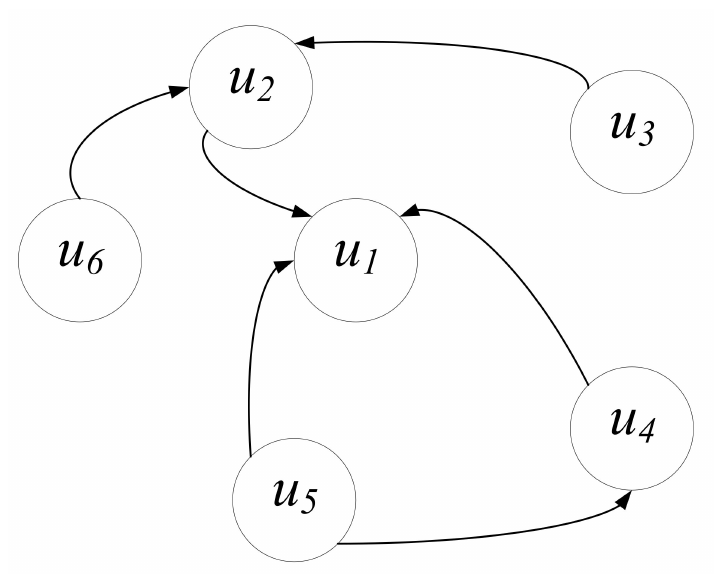
Figure 2. The retweet relationship between users in social